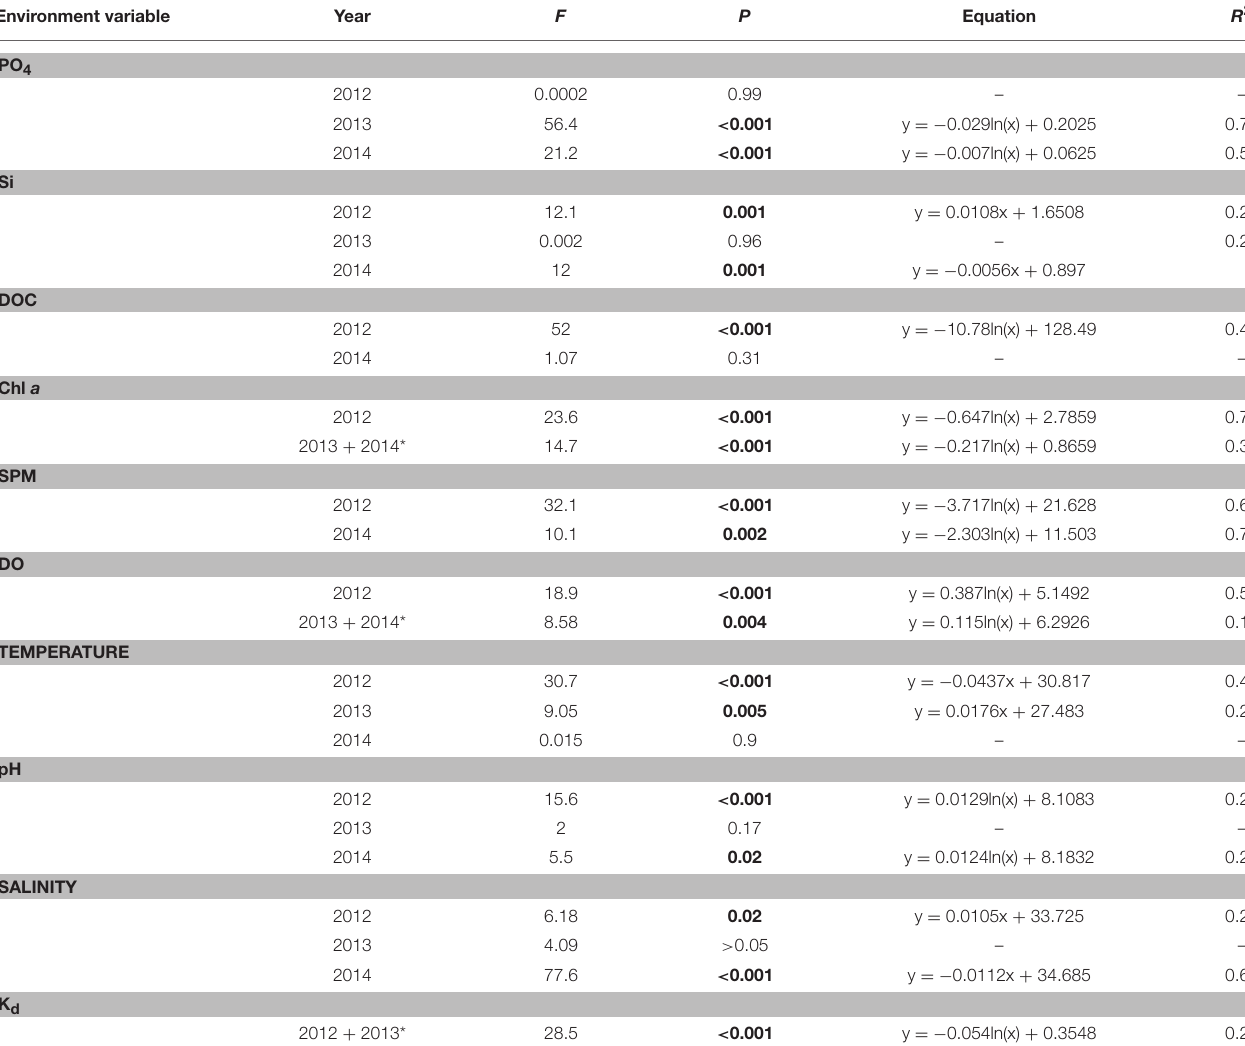
TABLE 1 | Results of regression analyses of environmental variables with distance from shore for all environmental variables that showed a significant difference with distance or an interaction effect in the PERMANOVA analysis (Table S1). Environment